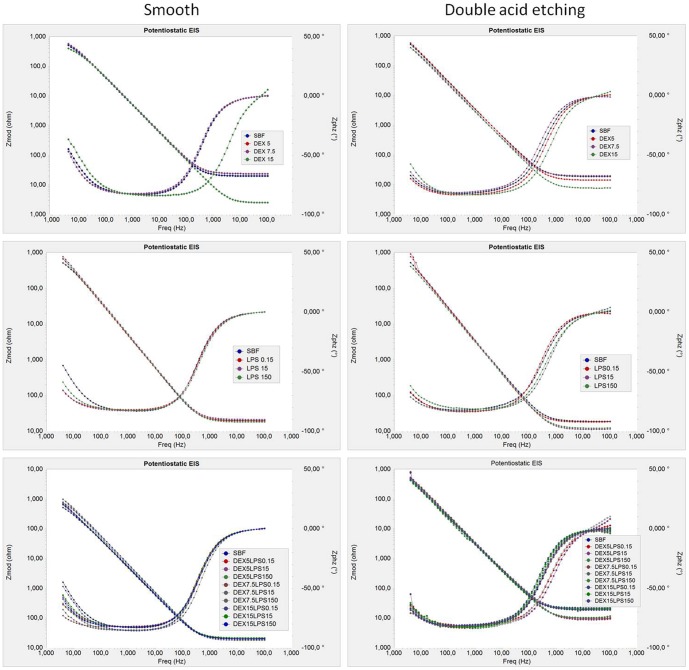
Electrochemical impedance spectroscopy (EIS) represented by the Bode plot of the Ti-6Al-4V alloy.Tests were conducted in simulated body fluid - SBF (control) with different concentrations of dextrose (DEX), lipopolysaccharide (LPS), and combinations of dextrose and lipopolysaccharide (DEXLPS).